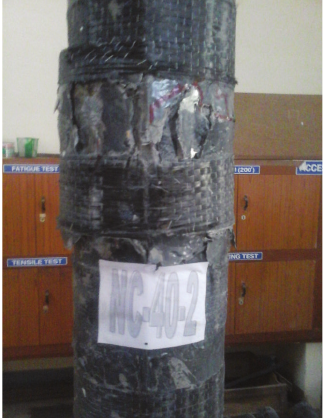
Figure 9: Failure pattern of NC-40-2.